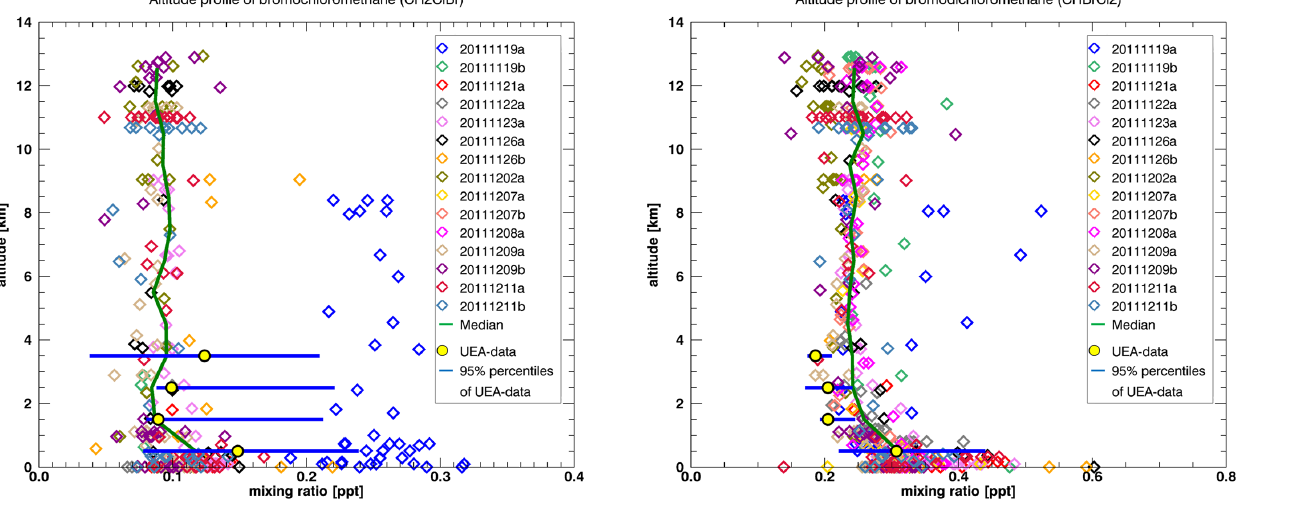
Figure 5. As Fig. 3, for CH 2 BrCl. Figure 6. As Fig. 3, for CHBrCl 2